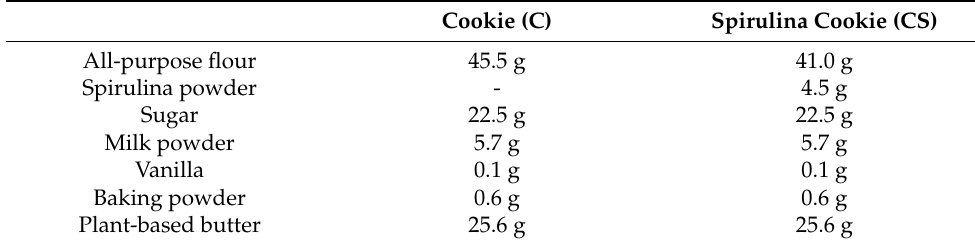
Table 2. Ingredient of cookie and spirulina cookie per 100 g.